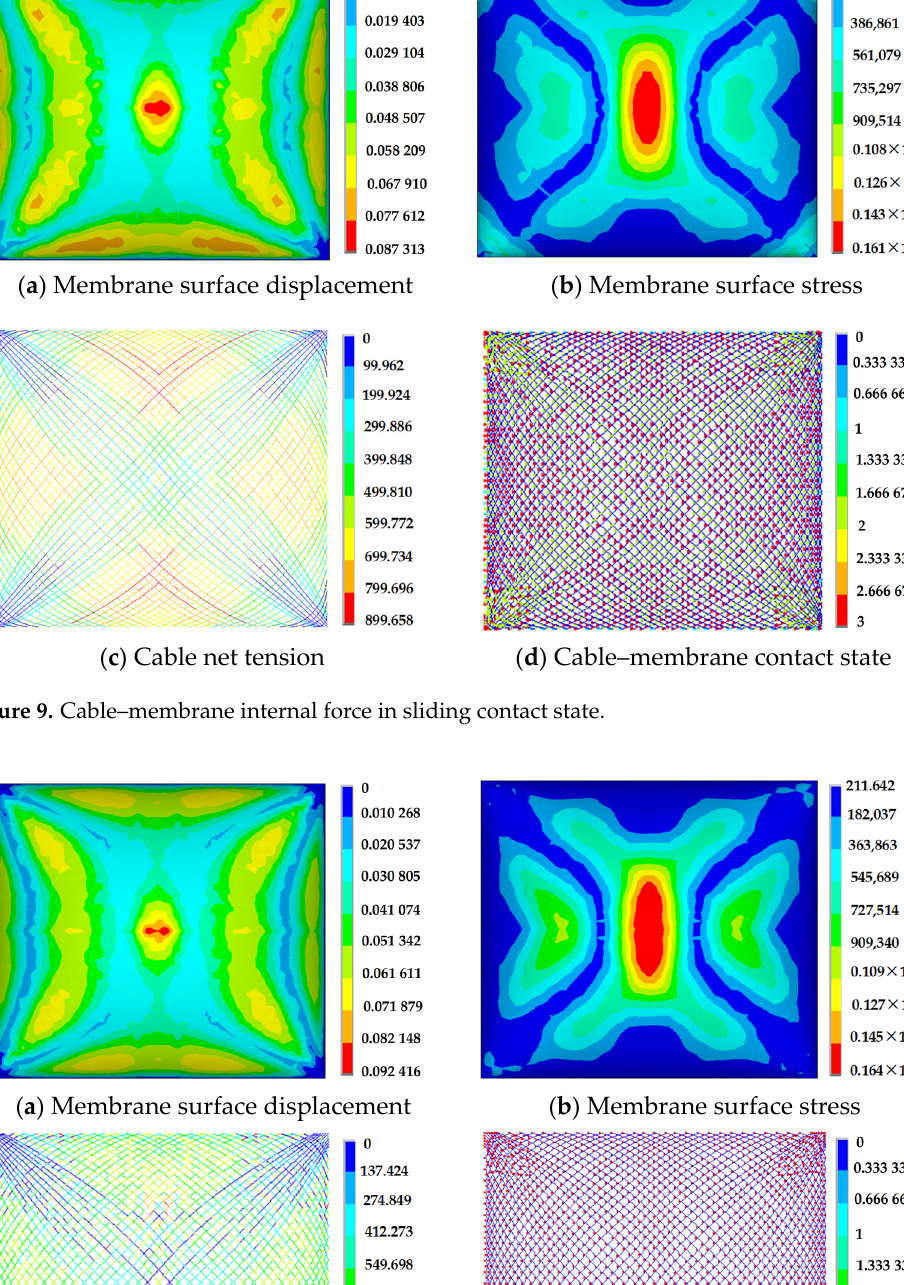
( b ) Acceleration cloud map Figure 8. Sliding Contact Analysis Results. Figures 9 and 10 show the membrane surface displacement, membrane surface stress, cable net tension and contact state cloud diagram between the cable and membrane, tak- ing into account various contact circumstances in the starting state of the model at 400 Pa internal pressure. In the cloud diagram of the contact state between the cable and mem- brane, the color in the 0–1 interval indicates that the cable–membrane contact state is a separation state, the 1–2 interval indicates that the cable–membrane contact state is a slid- ing state, and the 2–3 interval indicates that the cable–membrane contact state is a bound state. According to the calculation results, it can be obtained that when the air-supported membrane structure is in the initial state, the cable nets in the sliding contact analysis and the binding contact analysis are less stressed at the corners and tops of the structure, and the membrane surface stress is relatively large at this position. The difference between the membrane surface displacement of the cable–membrane sliding contact analysis and the membrane surface displacement of the binding contact analysis is very small. The differ- ence of the maximum stress of the membrane surface of the two contact analyses is also very small. However, the minimum stress of the membrane surface of the binding contact